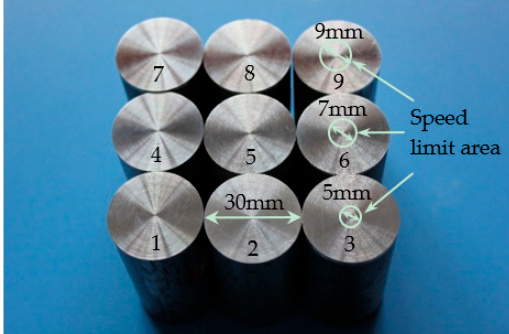
Figure 2. Image of the front end faces of samples 1 to 9.